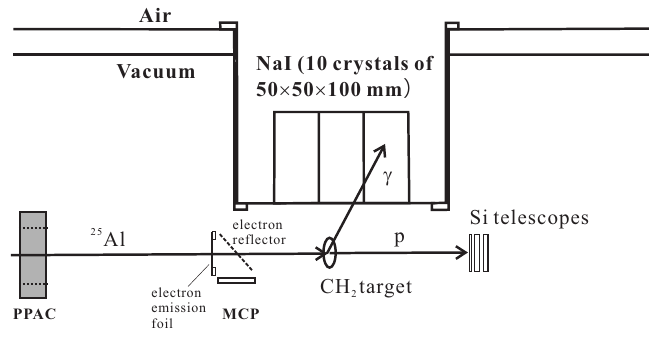
Figure 1. Schematic diagram (side view) of the experimental setup at F3 chamber.